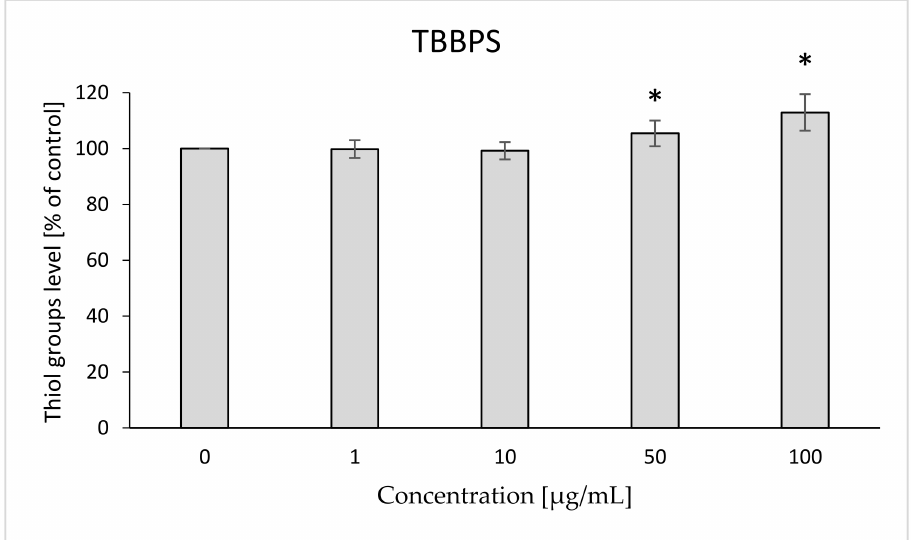
Figure 4. Changes in the thiol groups level in human control erythrocytes and the erythrocytes incubated with TBBPS at 1 to 100 µ g/mL for 12 h. (*) Significantly different from control ( p <